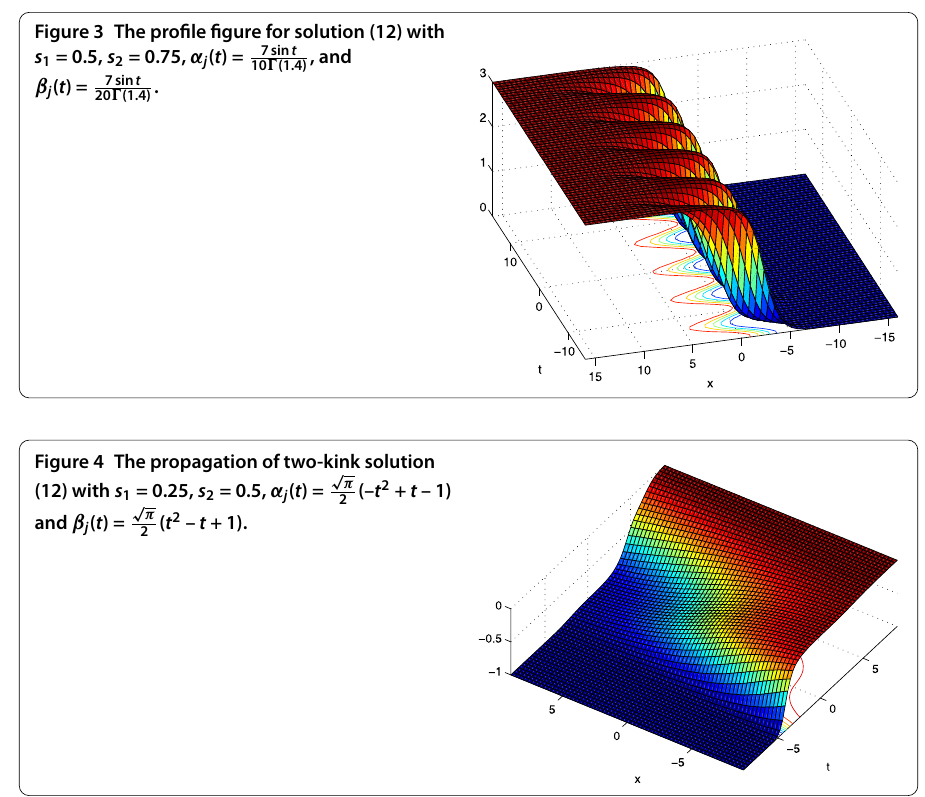
Figure 3 The profile figure for solution (12) with s 1 = 0.5, s 2 = 0.75, α j ( t ) = 7sin t , and 10 (cid:6) (1.4) β j ( t ) = 7sin t . 20 (cid:6) (1.4)